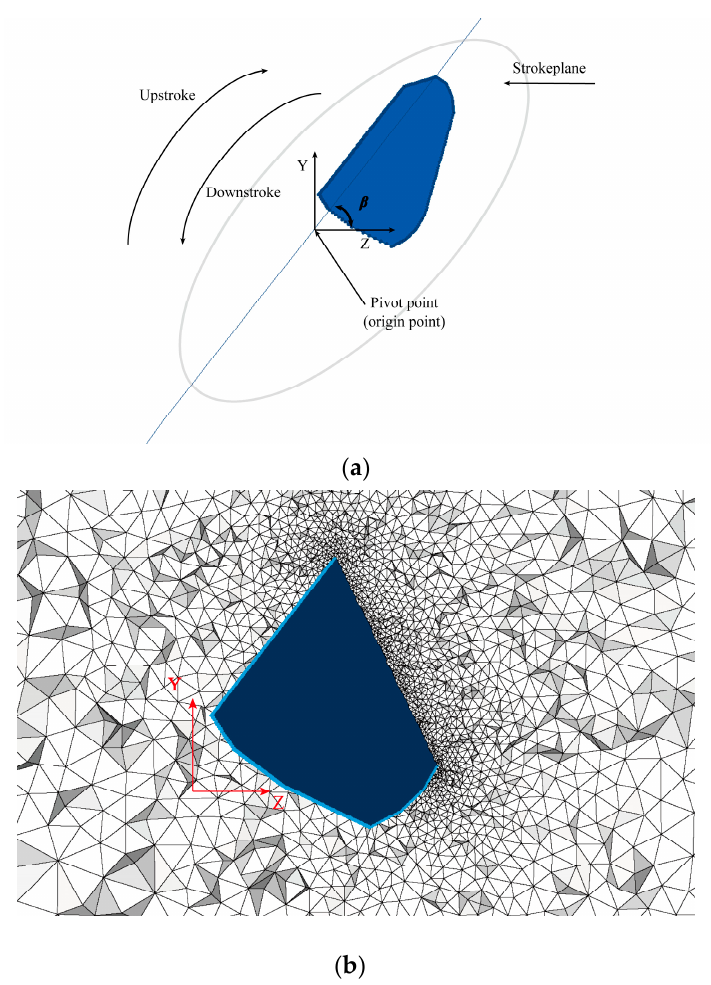
Figure 6. Mesh grid (fine) and motion parameters for the simulation of a dragonfly hindwing during hovering motion in the initial time step. ( a ) Flapping motion parameters in the initial time step; ( b ) grid of computational flow field in the initial time